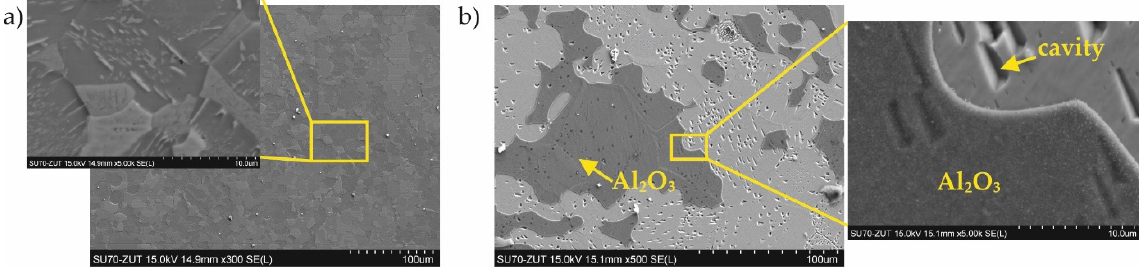
Figure 11. Microstructure of the sample with the coating manufactured in ( a ) 1000 °C, 2 h and ( b ) 1000 °C, 2 h with additional oxidation in 1000 °C during 5 min after 200 h of nitriding.